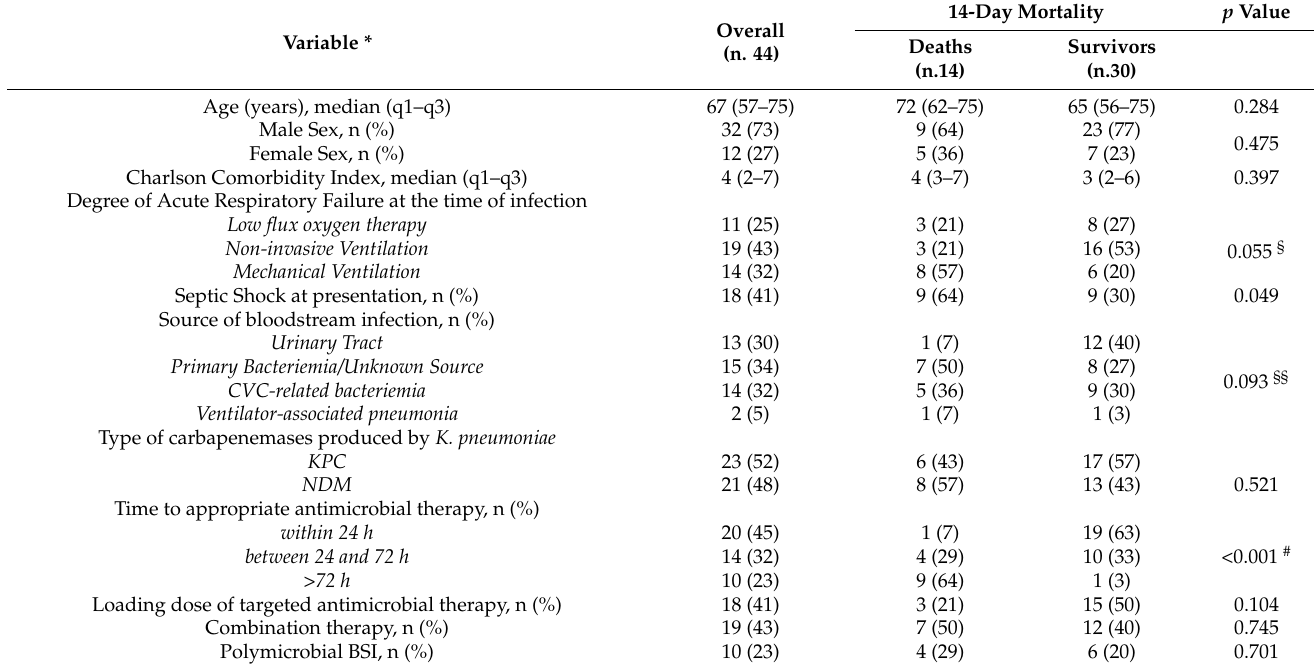
Table 3. Analysis of determinants of 14-day